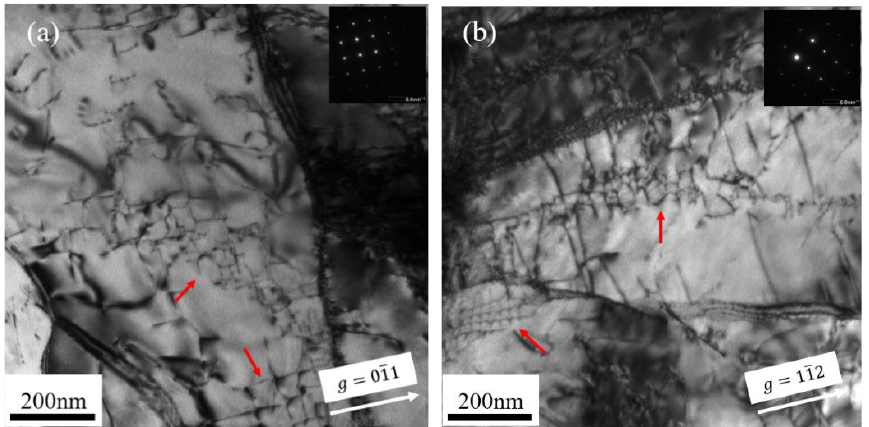
Figure 6. TEM bright-field micrographs showing the microstructure of Fe-Cr alloys irradiated at 550 °C; red arrows indicate the network dislocations: ( a ) Fe-9Cr imaged along the (100) zone axis; ( b ) Fe-9Cr-C imaged along the (110) zone axis.